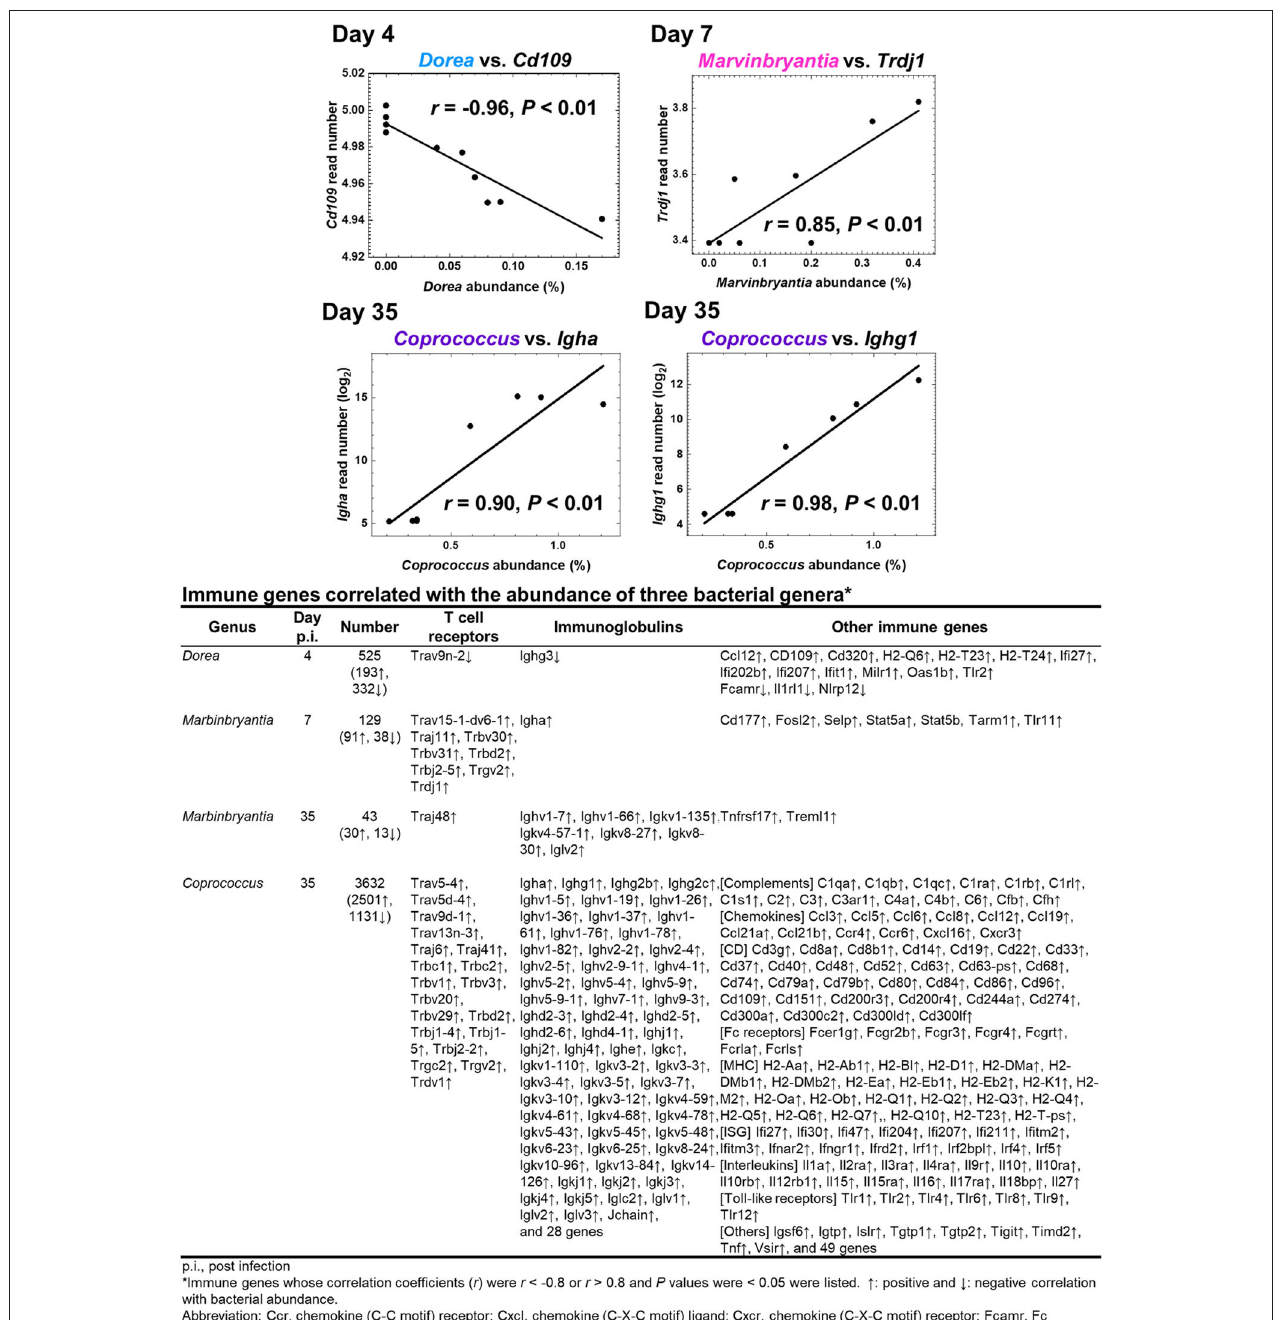
FIGURE 6 | Correlations of relative abundance of three fecal bacterial genera with CNS gene expressions. The correlations were determined by pattern matching between fecal microbiome and CNS transcriptome data. (Top) Representative genes correlated with bacterial relative abundance: day 4, Dorea , negative correlation with Cd109 ; day 7, Marvinbrynantia positive correlation with TCR δ ( Trd ); and day 35, Coprococcus positive correlation with Ig heavy chain α gene ( Igha ) and Ig heavy chain γ 1 ( Ighg1 ). (Bottom) A list of representative genes correlated with relative abundance of three genera positively ( ↑ , r > 0.8), or negatively ( ↓ , r < − 0.8); complete gene lists were shown in Supplemental Table 4 . We calculated correlation coefficients between bacterial relative abundance vs. CNS gene expressions that were significantly different between control and TMEV groups by R and listed the correlated genes whose P values < 0.05.